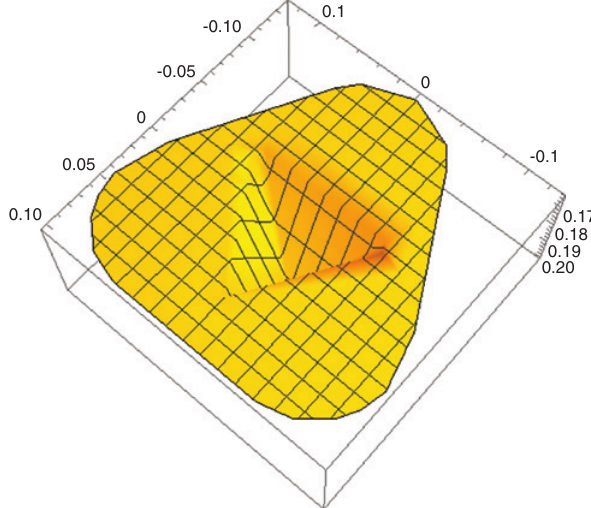
Figure 1: Displacement field given by Eq. (1), following the geometry of a Berkovich